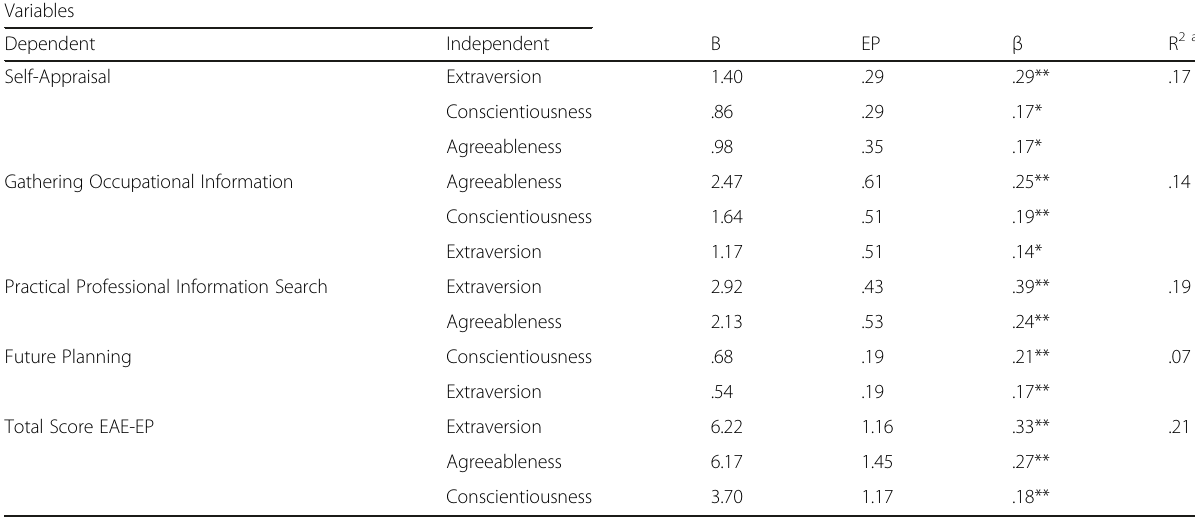
Table 1 Multiple regression